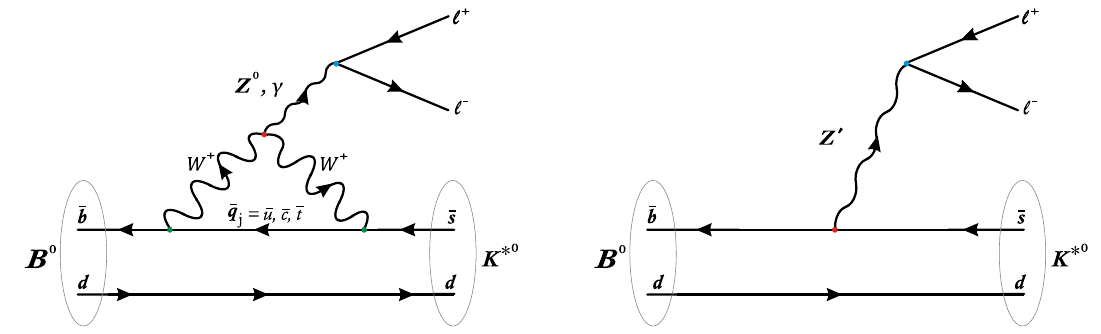
Fig. 1 Left panel: Example of a Feynman diagram contributing to B 0 → K ∗ l + l − in the SM context. Right panel: Tree level contribution in models with non-universal Z (cid:2)